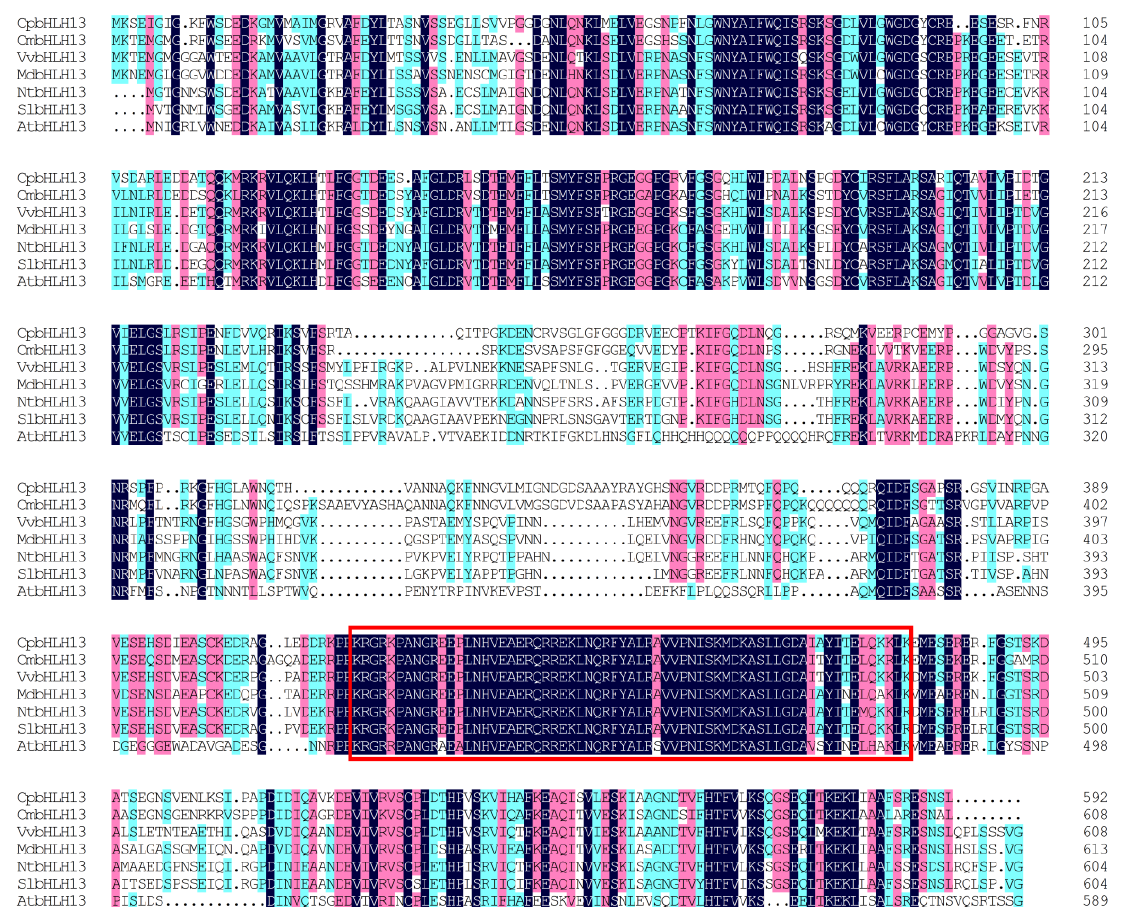
Figure 3. Multiple sequence alignment of the Wintersweet bHLH13 protein sequence with its homologous proteins from other plant species: Cinnamomum micranthum CmbHLH13 (RWR96436.1), Vitis vinifera VvbHLH13 (RVW95465.1), Malus domestica MdbHLH13 (XP_028955372.1), Nicotiana tabacum NtbHLH13 (XP_016459177.1), Solanum lycopersicum SlbHLH13 (XP_004229991.1), and Arabidopsis thaliana AtbHLH13 (AT1G01260). The red box indicates the basic helix-loop-helix DNA-binding domain common in plants. Table 2. Summary of the homology of wintersweet CpbHLH13 with genes from other Table 1. Summary of the homology of wintersweet CpMYC2 with genes from other plants.